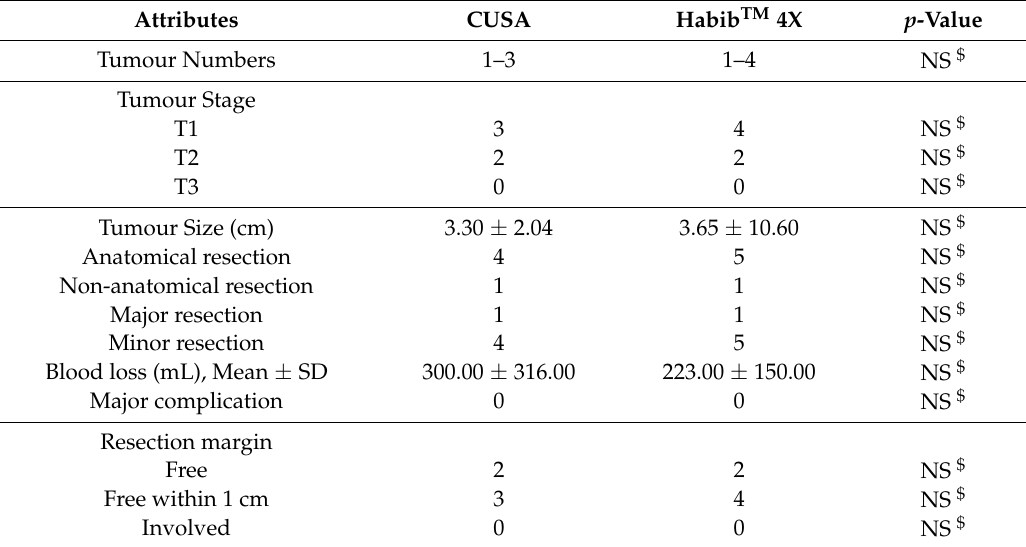
Table 2. Pre and postoperative tumour characteristics of patients in study